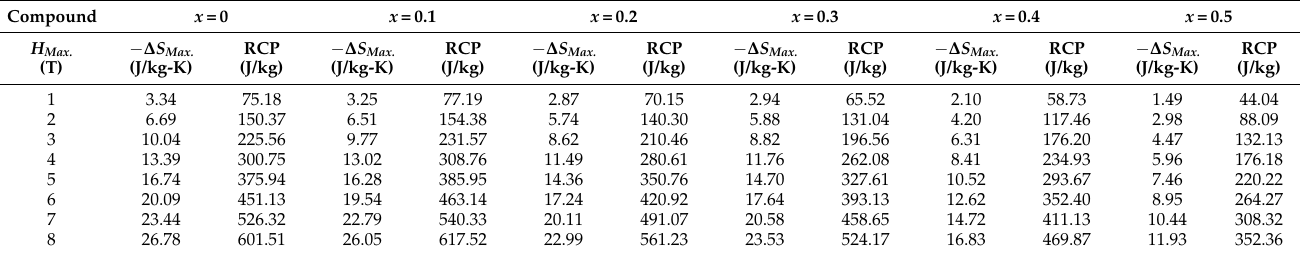
Table 4. Magnetic entropy change ( − ∆ S ) and relative cooling power (RCP) at different